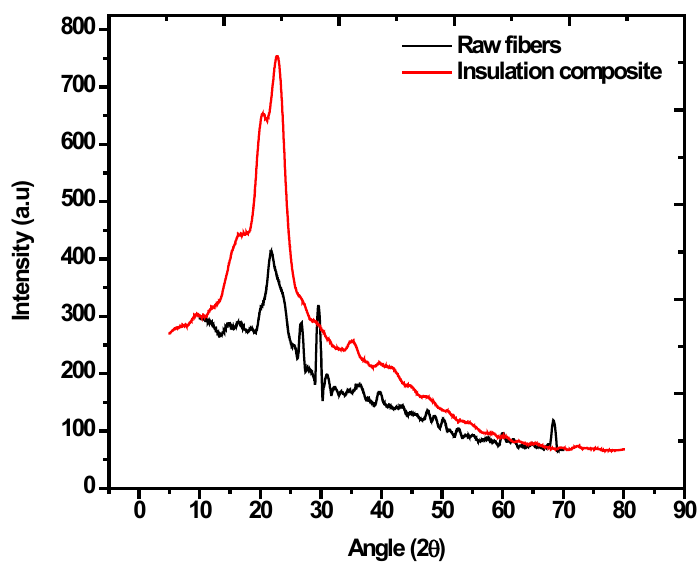
Figure 16. XRD analysis of raw fibers and insulation composite.